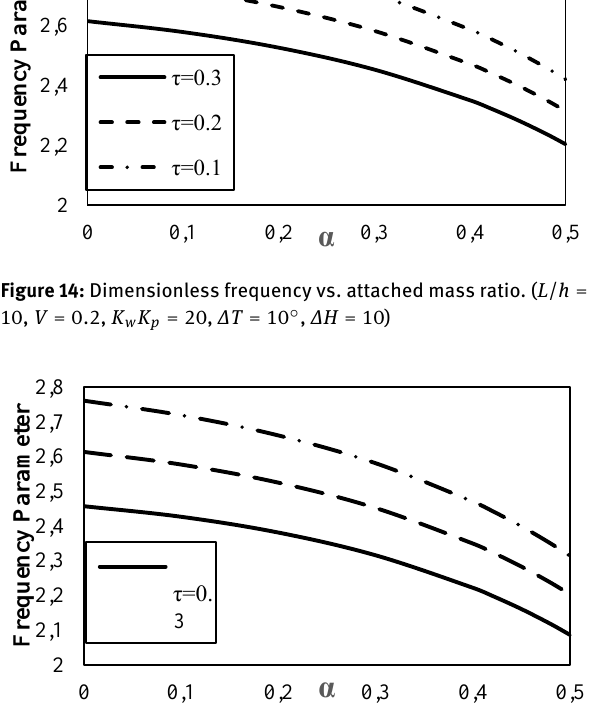
K p = 20, and for different environmental conditions, ( ∆T , ∆C ) = (10,10), (20,20), respectively. It is seen that the